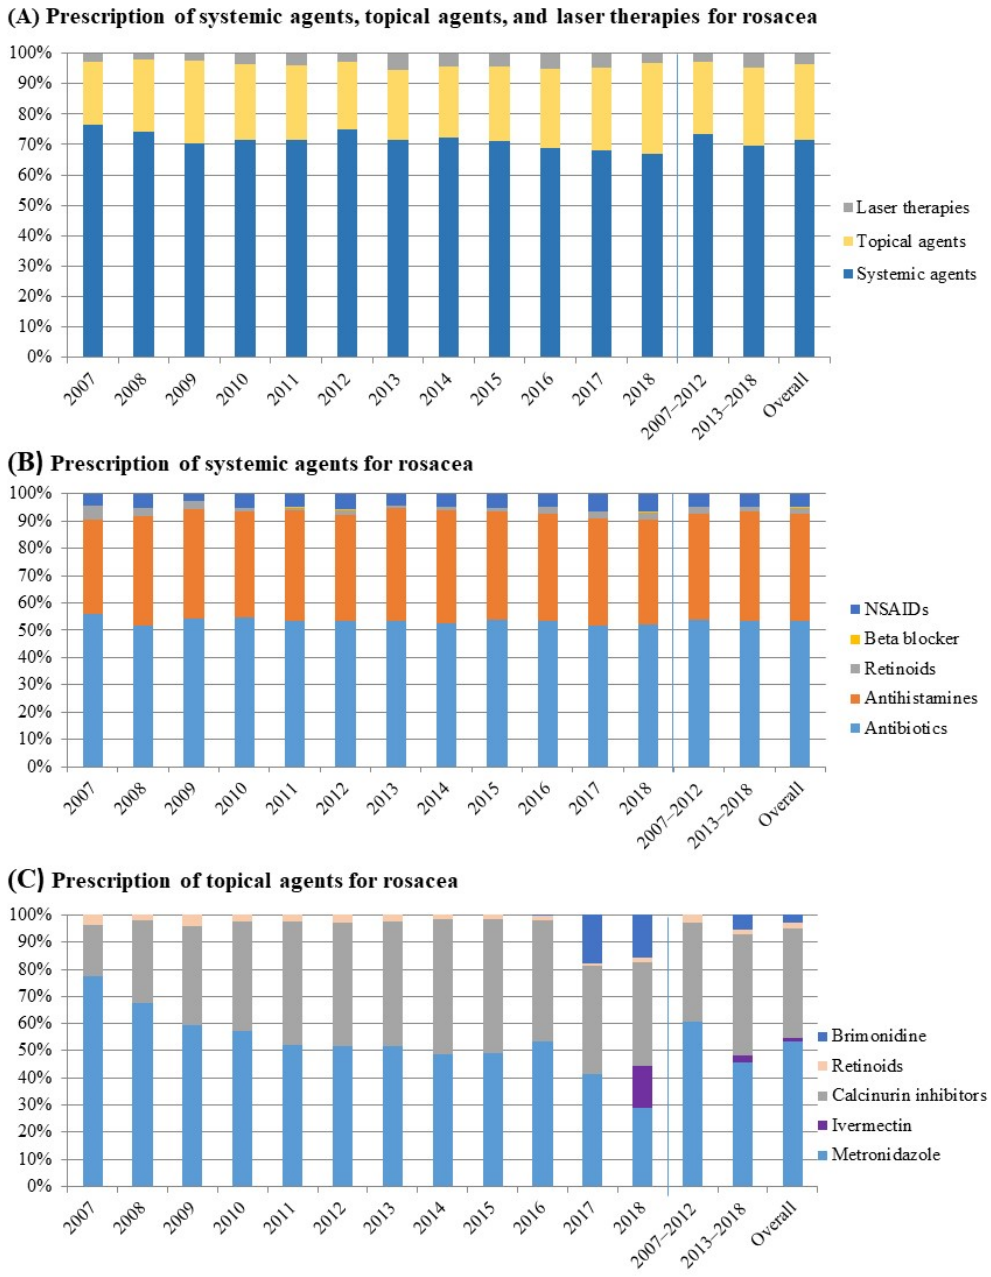
Figure 3. Trends in prescription patterns of rosacea. ( A ) Prescription of systemic and topical agents, and laser therapies for rosacea. ( B ) Prescription patterns of various systemic agents in rosacea. ( C ) Prescription patterns of various topical agents in rosacea.